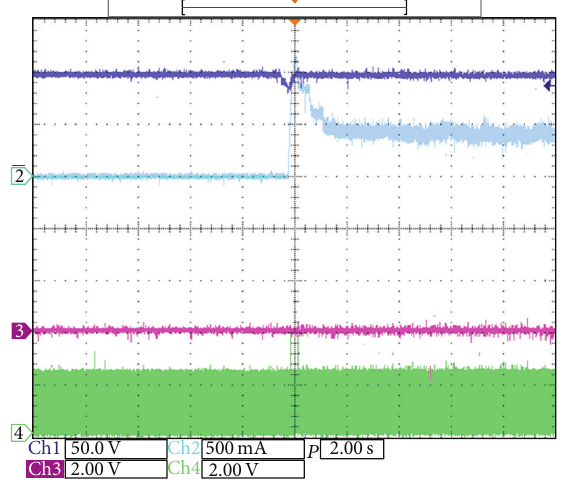
Figure 17: Operation when suddenly the maximum power energy of the renewable source becomes higher than the output power from , 𝑆 2 , and 𝑆 1 . top to bottom: 𝑉 𝑜 , −𝐼 𝐿 2